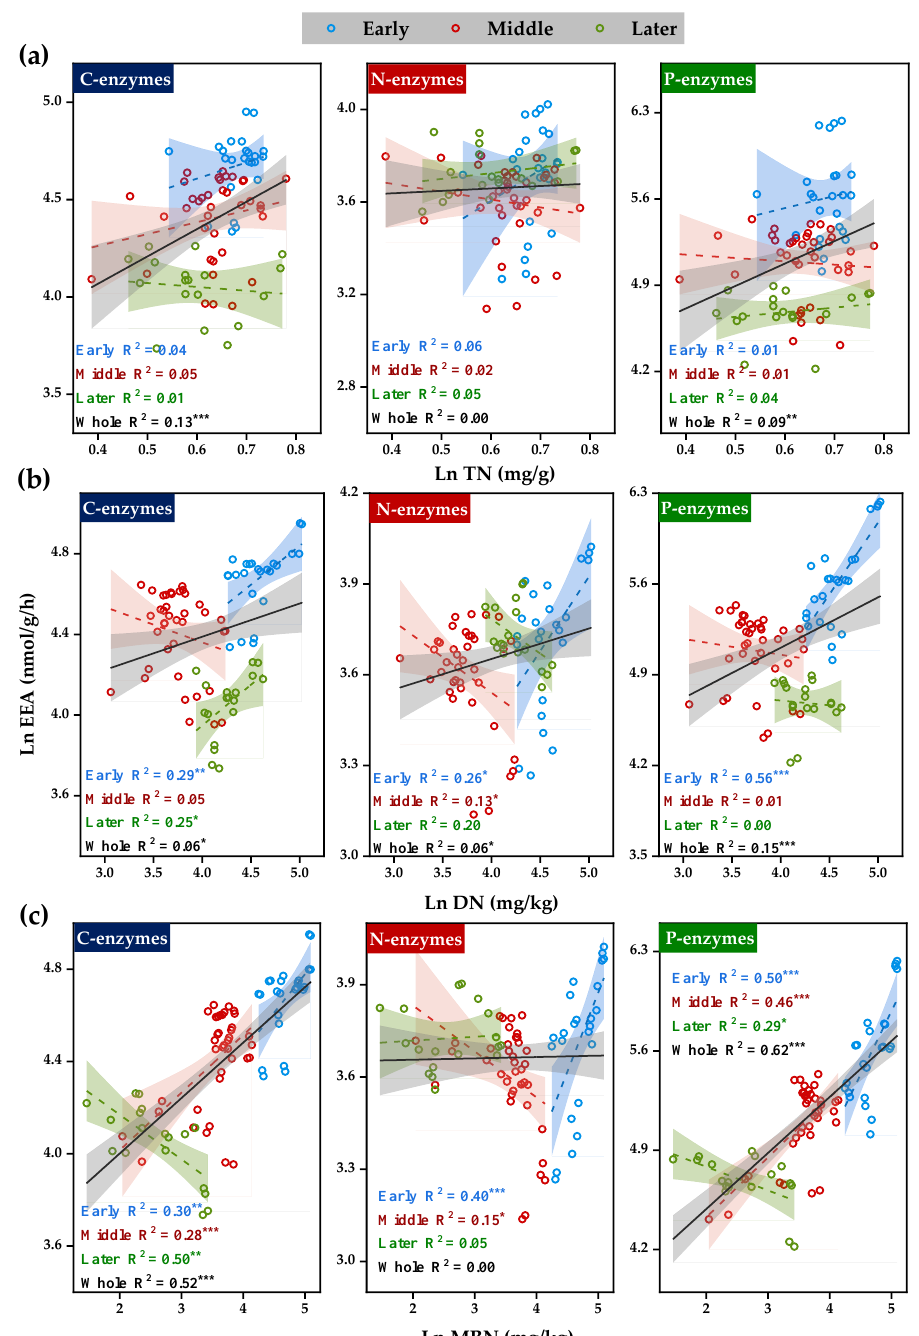
Figure 4. Relationship between soil extracellular enzyme activities (EEAs) and soil nitrogen fractions. ( a ) C-enzymes (BG+CBH) and total nitrogen (TN); N-enzymes (LAP+NAG) and TN; P-enzymes (AP) and TN. ( b ) C-enzymes and dissolved nitrogen (DN); N-enzymes and DN; P-enzymes and DN. ( c ) C-enzymes and microbial biomass nitrogen (MBN); N-enzymes and MBN; P-enzymes and MBN. * p < 0.05, ** p < 0.01, and *** p < 0.001.